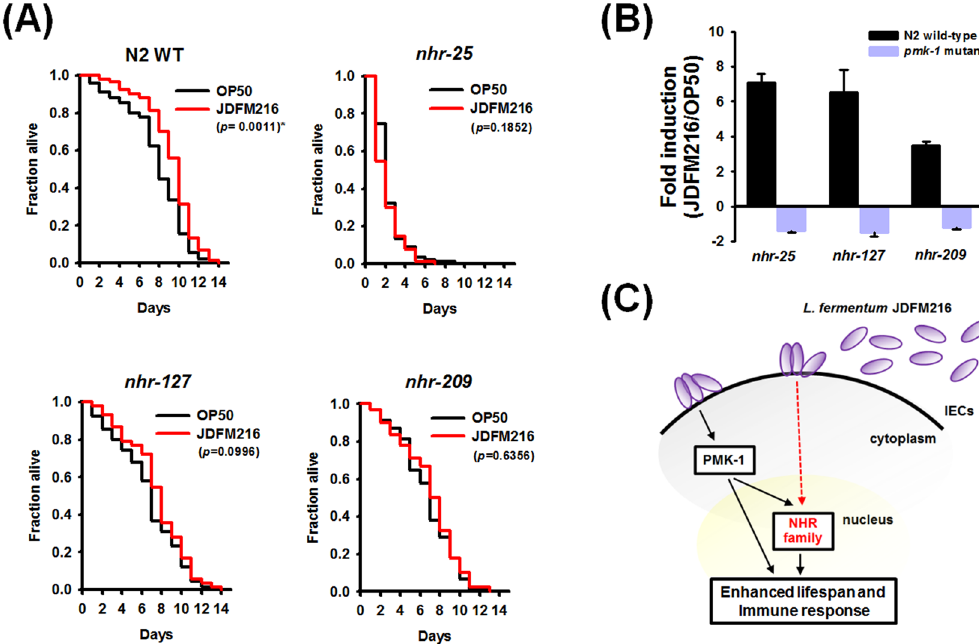
Figure 4. ( A ) NHR family is required for regulation of aging in C. elegans by Lactobacillus fermentum strain JDFM216. Lifespan assay of C. elegans strain N2 wild-type worms and loss-of function mutants including nhr- 25 , nhr-127 , or nhr-209 [Survival statics: wild-type N2 (p = 0.0011 worms conditioned with JDFM216 compared to OP50), nhr-25 (p = 0.1852 worms conditioned with JDFM216 compared to OP50), nhr-127 (p = 0.0996 worms conditioned with JDFM216 compared to OP50), and nhr-209 (p = 0.6356 worms conditioned with JDFM216 compared to OP50)]. ( B ) qRT-PCR analysis evaluating the regulation of selected NHR genes associated with PMK-1 signaling. Transcript levels were measured in young adult N2 wild-type or pmk-1 mutant worms conditioned with JDFM216 for 24 h. ( C ) Schematic mechanisms of enhanced lifespan and immune response of L. fermentum strain JDFM216 via NHR family and PMK-1